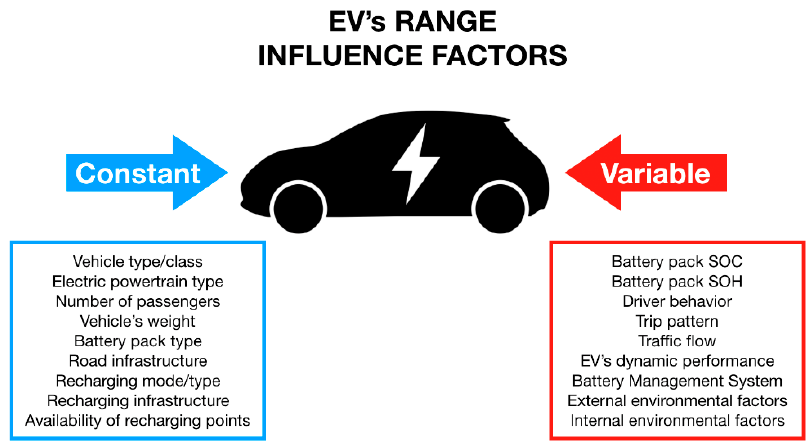
Figure 2. The main influence factors on EV’s range (constants and variables).